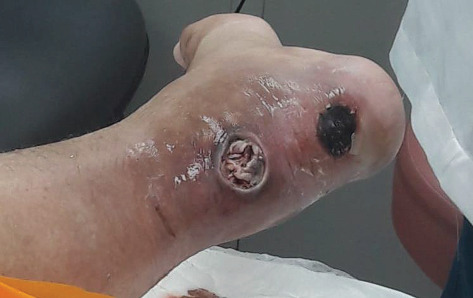
Wound presentation.